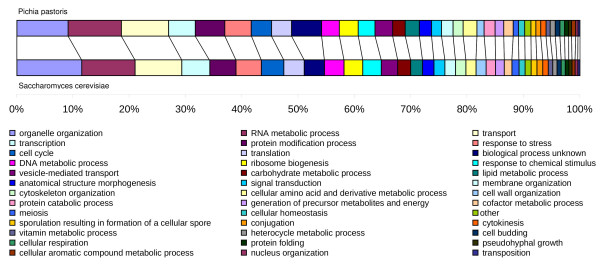
Categorization of the P. pastoris annotated genome compared to S. cerevisiae. The GO functional groups are displayed based on their relative representation with annotated ORFs.